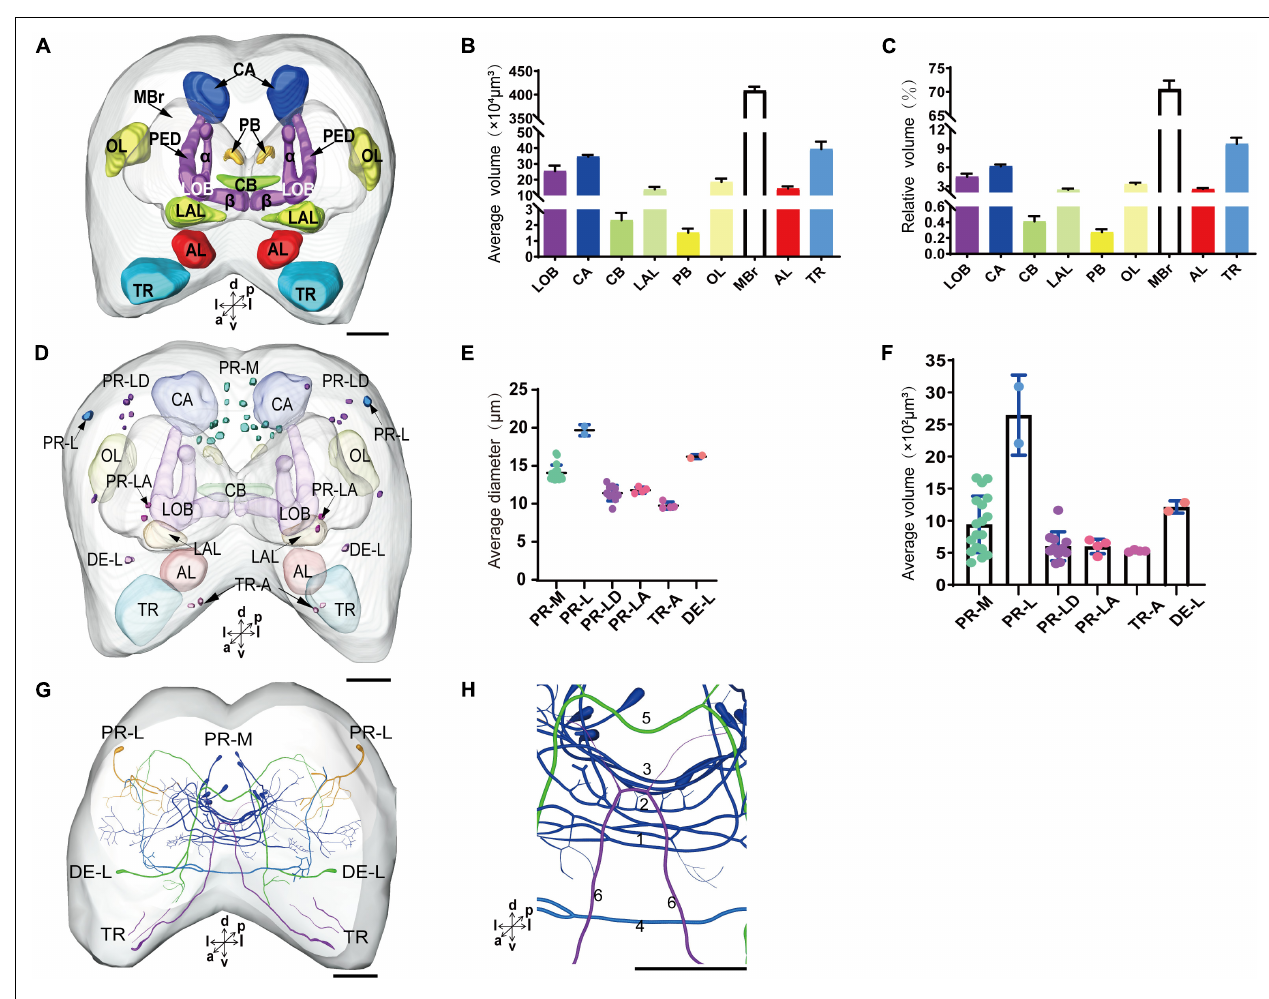
FIGURE 2 | The average and relative volume of the neuropils, the average diameter and volume of cell bodies, and the distribution of the serotonergic neuronal processes and cell bodies in the brain. (A) Three-dimensional reconstructions of the neuropils in the brain in frontal view. (B,C) The average and relative volume of the neuropils. (D) Reconstructions of cell bodies in the brain. (E,F) The average diameter and volume of cell bodies in the brain. (G) Reconstructed skeleton trees of the thick neuronal processes showing their projection patterns in anterior view. (H) Reconstructed skeleton trees of commissures 1–6 in anterior view. PR-M, PR-L, PR-LD, PR-LA, DE-L, and TR-A are cell clusters. α , alpha lobe; AL, antennal lobe; β , belta lobe; CA, calyx; CB, central body; LAL, lateral accessory lobe; LOB, mushroom body lobes; OL, optic lobe; PB, protocerebral bridge; TR, tritocerebrum. Directions: a, anterior; d, dorsal; l, lateral; m, medial; p, posterior; v, ventral. Scale bar, 100 µ